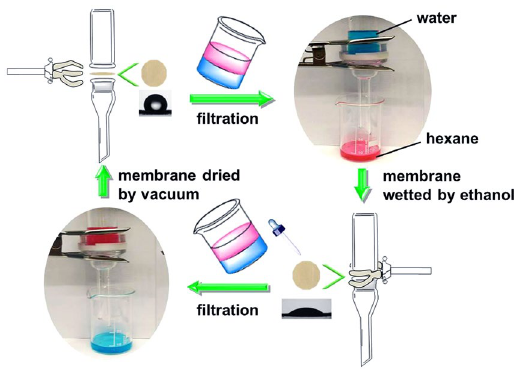
Figure 4. Illustration of the switchable oil/water separation process with the solvent-responsive membrane PPHM-3. The membrane PPHM-3 without treated with ethanol can let hexane pass through but not water; after ethanol treatment, it can let water pass through but not